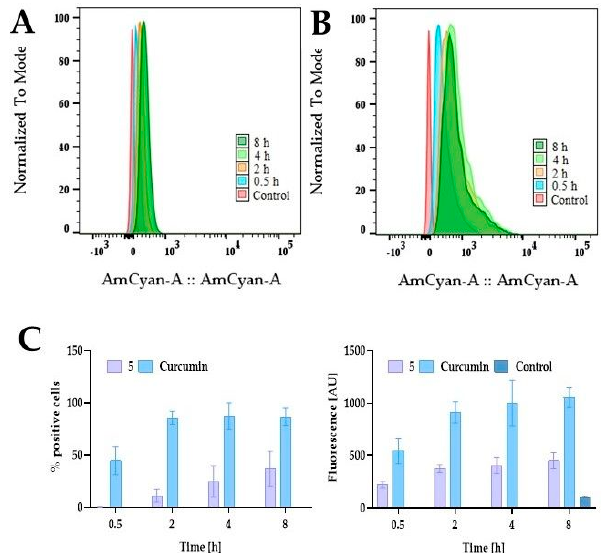
Figure 11. The time-dependent uptake of compound 5 and curcumin by 5637 cells. Based on the literature data, curcumin has extensive absorption around 408–430 nm and can emit fluorescence around 460–560 nm, while excitation and emission wavelengths of compound 5 are 436 nm and 530 nm, respectively. Panel ( A ) presents the representative histograms for compound 5, and panel ( B ) for curcumin. Panel ( C ) presents quantitative analysis as the percent of positive cells and mean fluorescence intensity. The 5637 cells were treated with compound 5 and curcumin at a concentration of 10 µ M for 0.5 h, 2 h, 4 h, and 8 h under standard cell culture conditions. The uptake was analyzed by flow cytometry (BD Lyric TM , Becton Dickinson, Franklin Lakes, NJ, USA) after excitation with a 405 nm laser and detection with a 505.5–550.5 band-pass filter (528/45). Data are presented as mean values ± SD from three